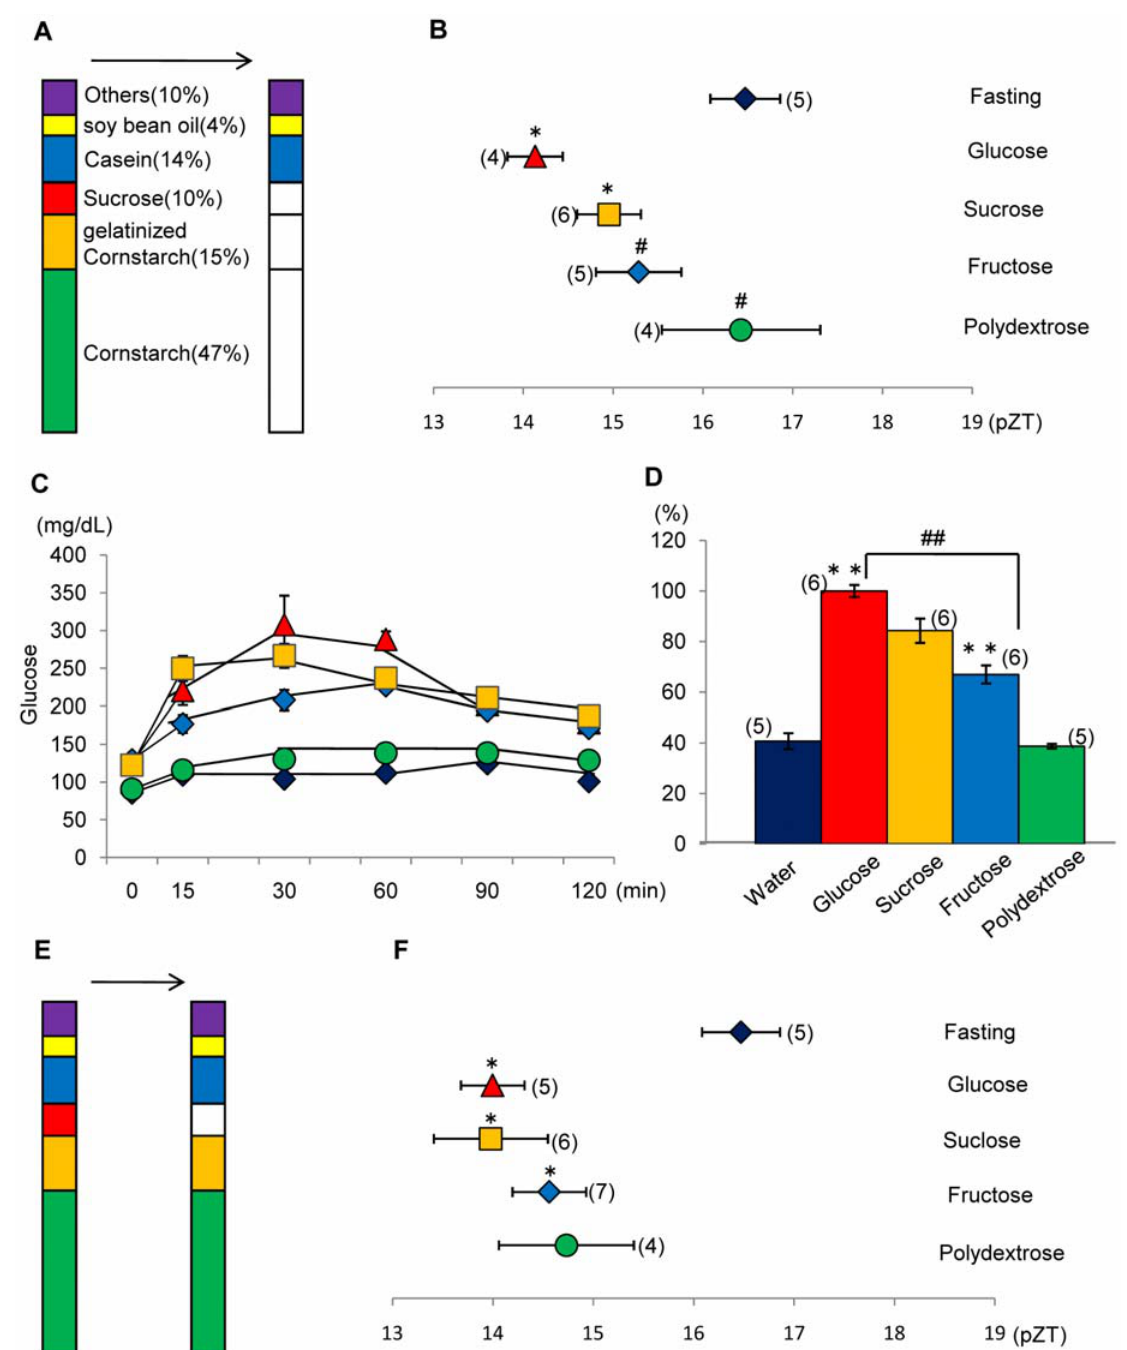
Figure 3. Effects of partial substitution by starch/sugar in the AIN-93M diet on the phase of the liver circadian clock and relative blood glucose value. A: Percent of each nutrient component in AIN-93M. The ‘other’ category comprised 3.5% AIN-93 mineral mixture, 1% AIN-93 vitamin mixture, 0.25% choline bitartrate, and 0.0008% tert-butyl hydroquinone. Substituted components are shown by the white column segments. B: Mice were administered a diet tablet containing 0.6 g/10 g BW of the substitute diet on the first day and 0.85 g/10 g BW of the substitute diet on the second day after 24-h food deprivation. Nutrient components of cornstarch, gelatinized cornstarch, and sucrose were replaced with glucose, sucrose, fructose, or polydextrose. The horizontal axis indicates the pZT at the peak of the bioluminescence rhythm. Fisher’s PLSD test. * P , 0.05 (vs. fasting). # P , 0.05 (vs. glucose). C: Time course of the blood glucose level after oral injection of 0.03 g/10 g BW of each substituted nutrient. The vertical axis indicates the content of glucose (mg/dL). The values indicate the mean 6 SEM. Symbol color of each treatment is the same as column color in part D. D: Relative blood glucose value (% of glucose) of nutrient substituted group. Fisher’s PLSD test. ** P , 0.01(vs. water). # P , 0.05, ## P , 0.01(vs. glucose). E: Percent component of each nutrient in AIN-93M. Substituted components are shown by white column. F: The component of 10% sucrose was substituted with 10% glucose, 10% fructose, or 10% polydextrose. The horizontal axis indicates the pZT at the peak of the bioluminescence rhythm. Fisher’s PLSD test. * P , 0.05 (vs. fasting). The numbers in parentheses indicate the number of tested mice. We used the same data for fasting and AIN-93M as mentioned in Fig. 1 to produce Fig. 3.